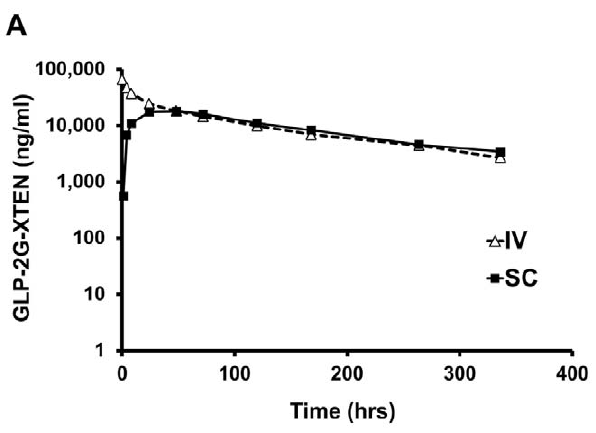
Figure 2. Pharmacokinetics of GLP2-2G-XTEN in cynomolgous monkeys. GLP2-2G-XTEN plasma concentration is shown following 25 nmol/kg administration via intravenous (triangle) or subcutaneous (square) route. Three animals were dosed by each route of adminis- tration. Data points are the average 6 s.d. of three animals per time point.